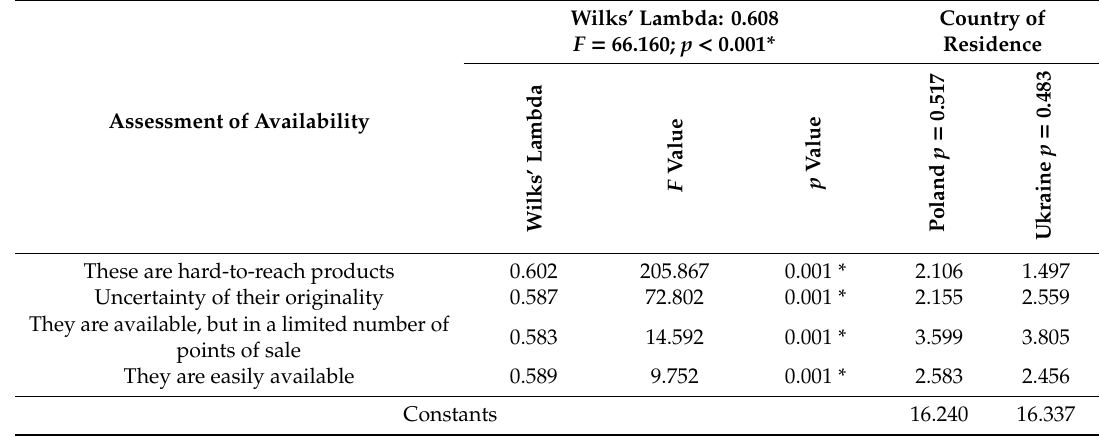
Table 4. Assessment of the availability of food regional products.